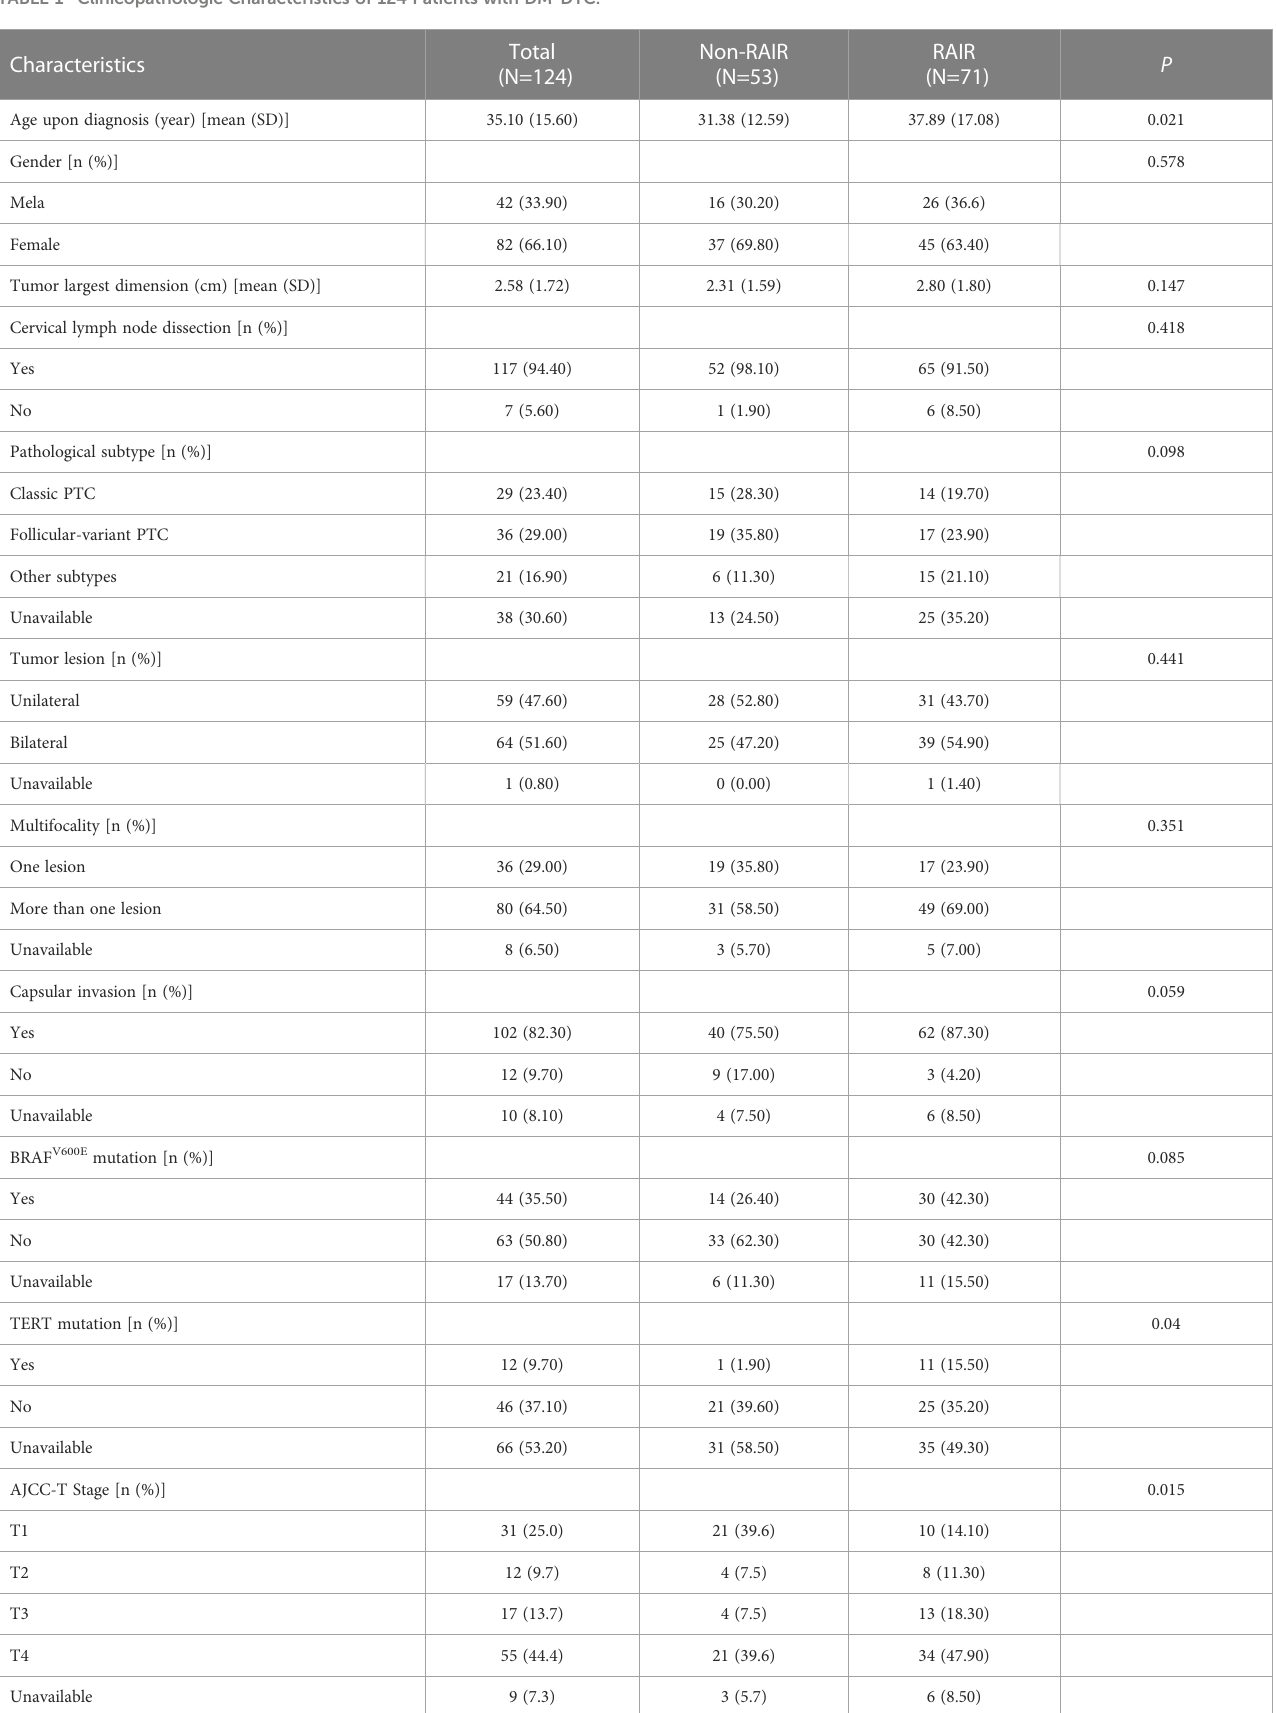
TABLE 1 Clinicopathologic Characteristics of 124 Patients with DM-DTC.